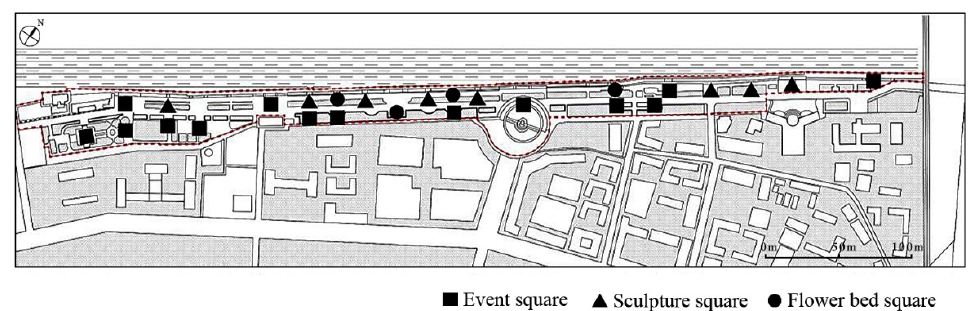
Figure 12. Types and location of leisure square in Harbin’s Stalin Park.